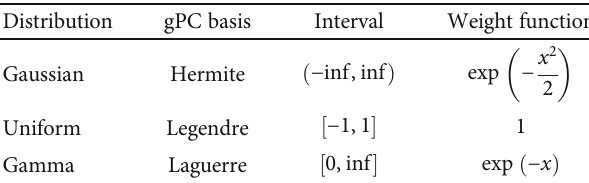
Table 2: gPC basis functions with the